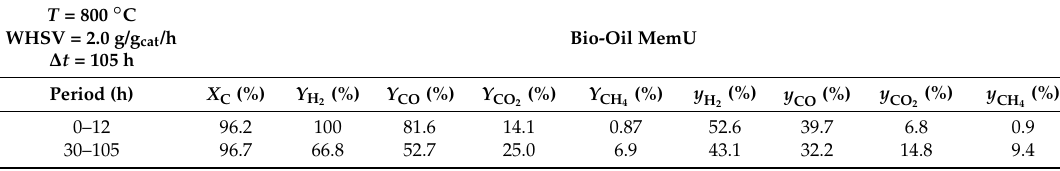
Figure 5. Concentration ( A ); and selectivity ( B ) profiles of bio-oil MemU SR at 800 °C, WHSV = 2.0 g/g cat /h and TOS = 105 h. Note: Peaks and outlier values that appear in the graph were due to burette refilling with bio-oil. Table 3. Long TOS test results of bio-oil MemU